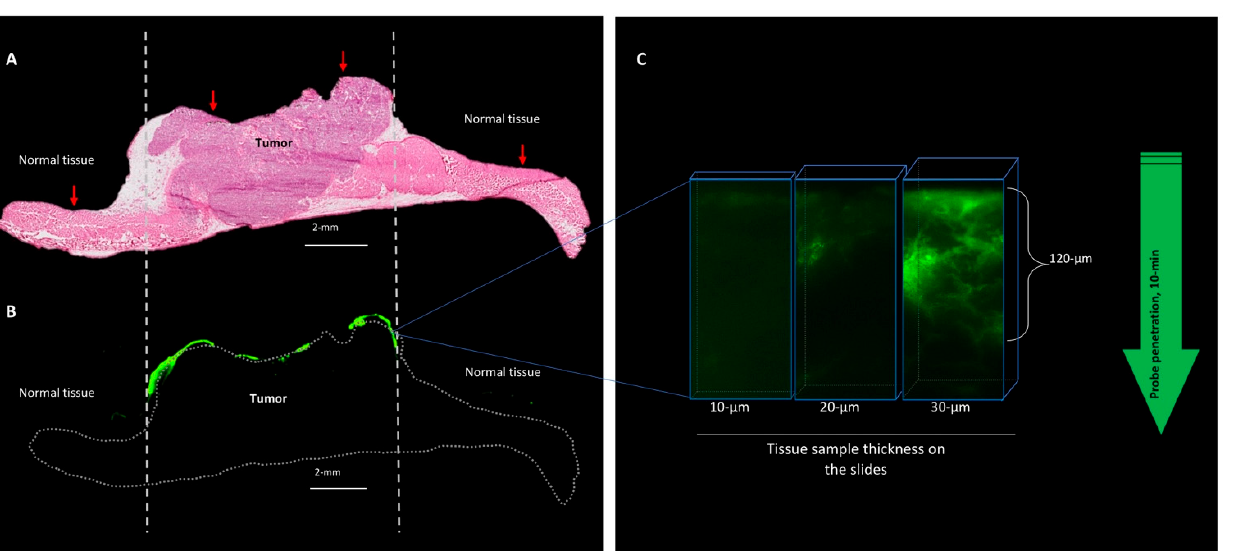
Figure 5. After topical application, AKRO-QC-ICG probe penetrates tissue to the depth of a few cancer cells. ( A )—H/E histology of the PDX cancer xenograft with surrounding normal tissue (abdominal wall muscles). Vertical dotted lines indicate tumor borders. ( B )—Fluorescent scan of consecutive tissue slide represents AKRO-QC-ICG-induced fluorescence (false green color), indicating that the probe was activated only at the area of the fresh cut surface of the tumor without a tendency to spread to surrounding tissues. Dotted line—contour of the sample. ( C )—Fluorescent microscopy consecutive tissue sections of different thickness indicate that AKRO-QC-ICG penetrates from the surface (where it was applied) to a depth of up to 120 µ m in 10 min. Thicker tissue sections were required to visualize probe fluorescence in tissue, avoiding the need for inking fluorescence prior to tissue preparation. For these studies, mice were treated with AKRO-QC-ICG imaging gel#30 and imaged as in Figure 3. Next, tissue was snap frozen and consecutive slides were sliced for routine histology, fluorescent scan (Odyssey CLx, resolution = 24 µ m, 800 nm filter set, Li-Cor) in ( B ) and microscopy (Leica, NIR filter set) in ( C ). Vertical red arrows indicate the surface of application and direction of future penetration of the probe in ( A